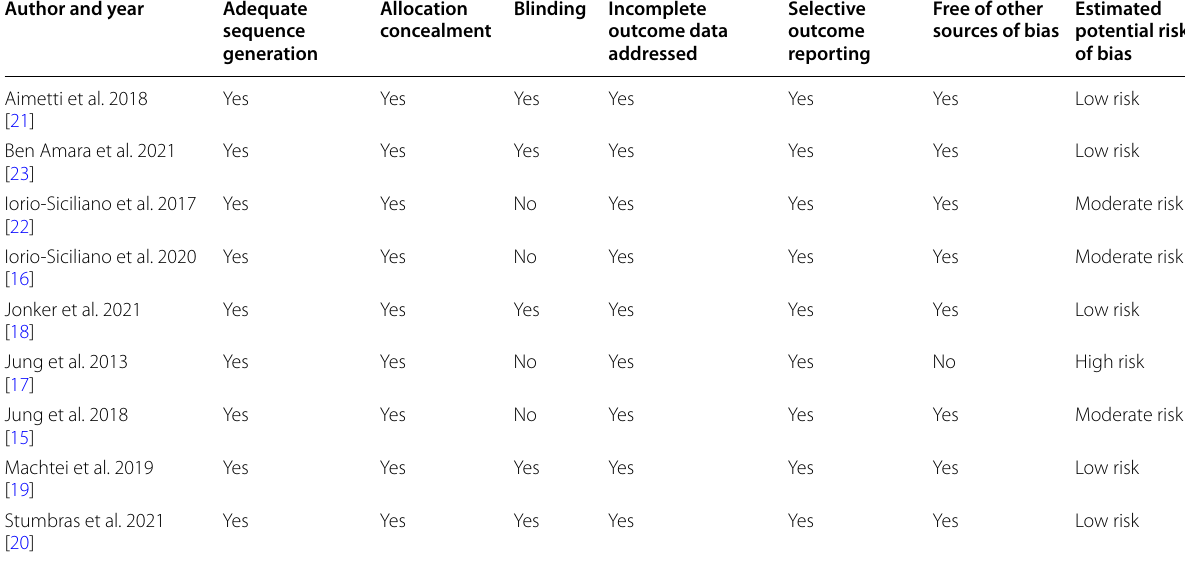
The studies meeting all of the criteria were classified as having a low risk of bias, while those that did not meet a criterion were classified as having moderate risk. When two or more criteria were not met, the studies were considered to have a high risk of